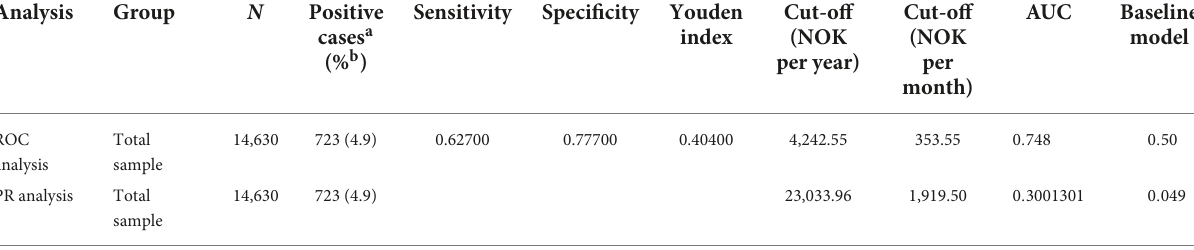
TABLE 4 Results from the receiver operating characteristic (ROC) analysis and the precision-recall (PR) analysis when setting the threshold of classification at moderate-risk gamblers.